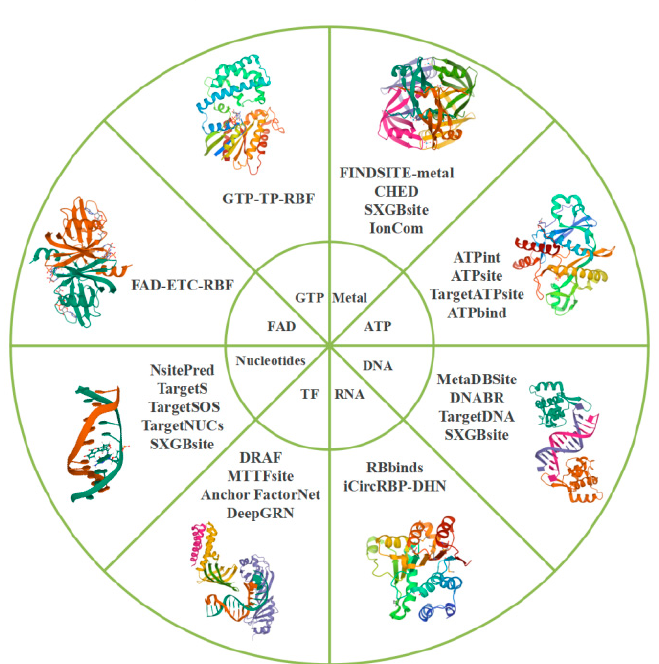
Figure 4. Tools used in ligand-specific methods to predict binding sites.